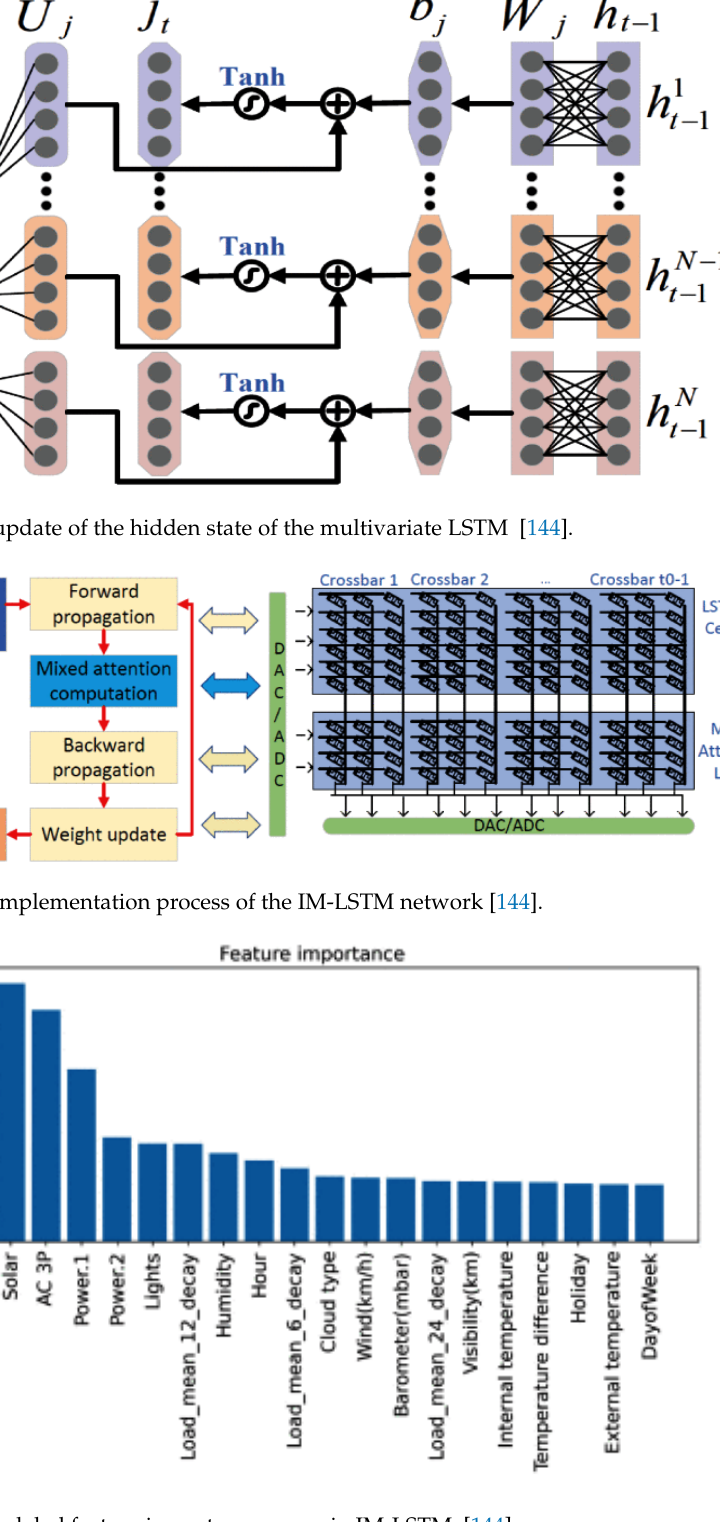
Figure 10. The global feature importance scores in IM-LSTM